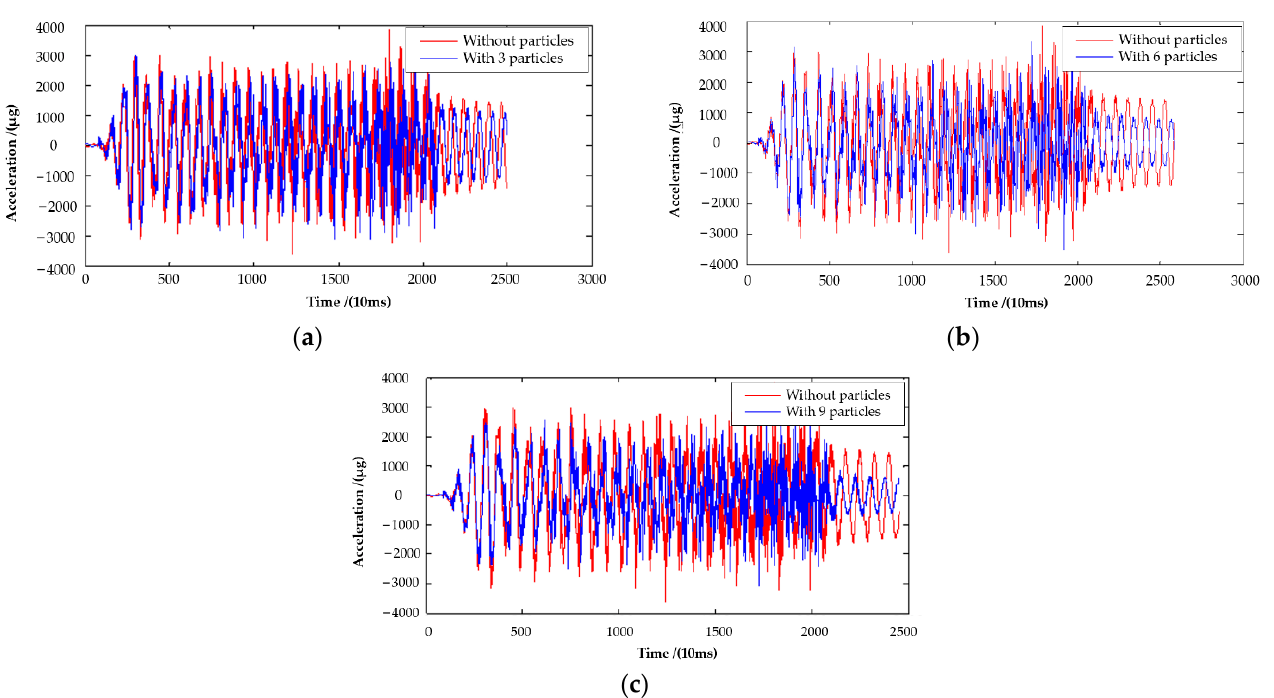
Figure 6. Acceleration responses of 3% mass ratio under sine sweep wave: ( a ) the particle number is 3; ( b ) the particle number is 6; ( c ) the particle number is 9.